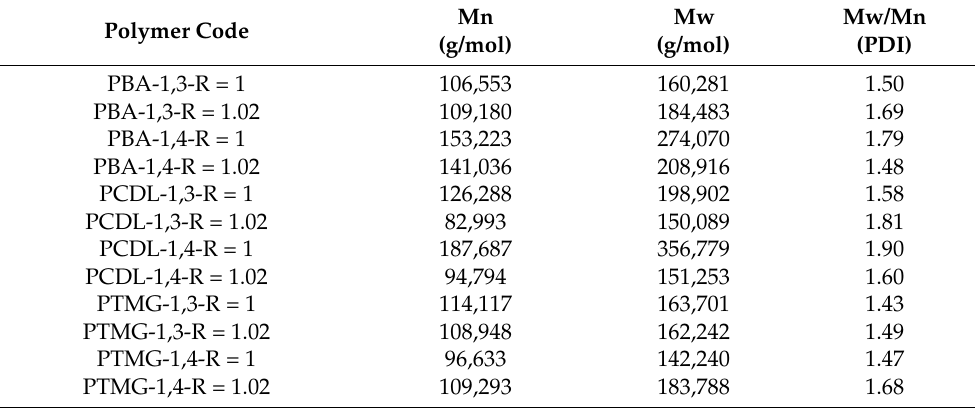
Table 3. Number-average molecular weight (Mn), weight-average molecular weight (Mw), and polydispersity index (PDI) of the TPUs synthesized in this